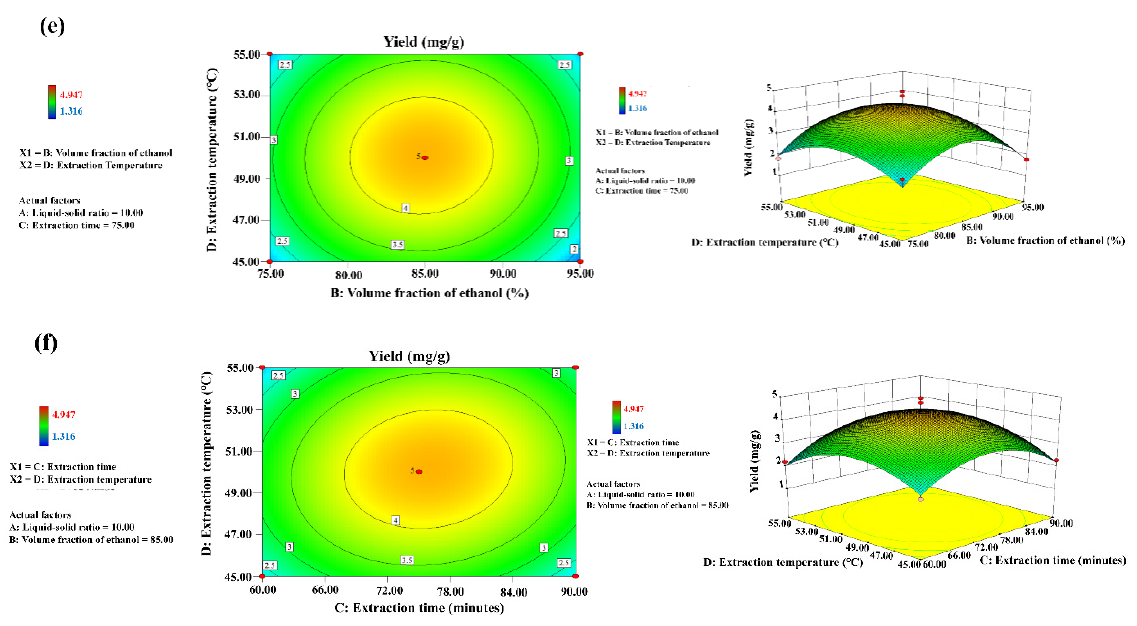
Figure 7. Two-dimensional (2D) contour plots and 3D response surface curves of extraction yield for the interaction effects between liquid-solid ratio and volume fraction of ethanol ( a ), liquid-solid ratio and extraction time ( b ), liquid-solid ratio and extraction temperature ( c ), volume fraction of ethanol and extraction time ( d ), volume fraction of ethanol and extraction temperature ( e ) and extraction time and extraction temperature ( f ).